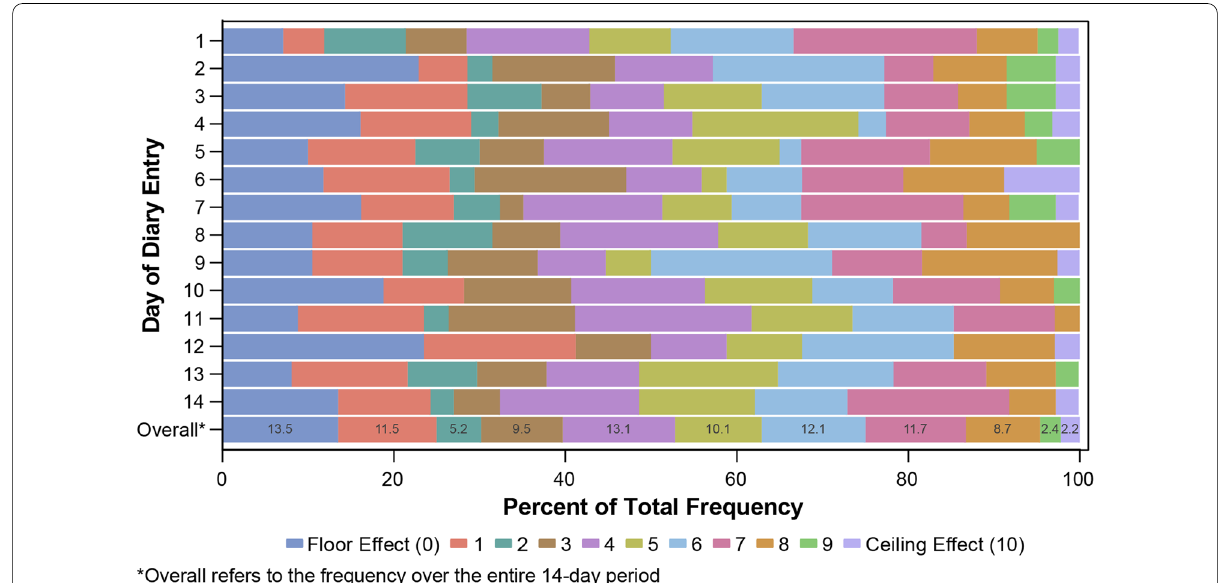
Fig. 2 Item distribution and floor/ceiling effects for Urgency NRS scores by day of 2‑week diary